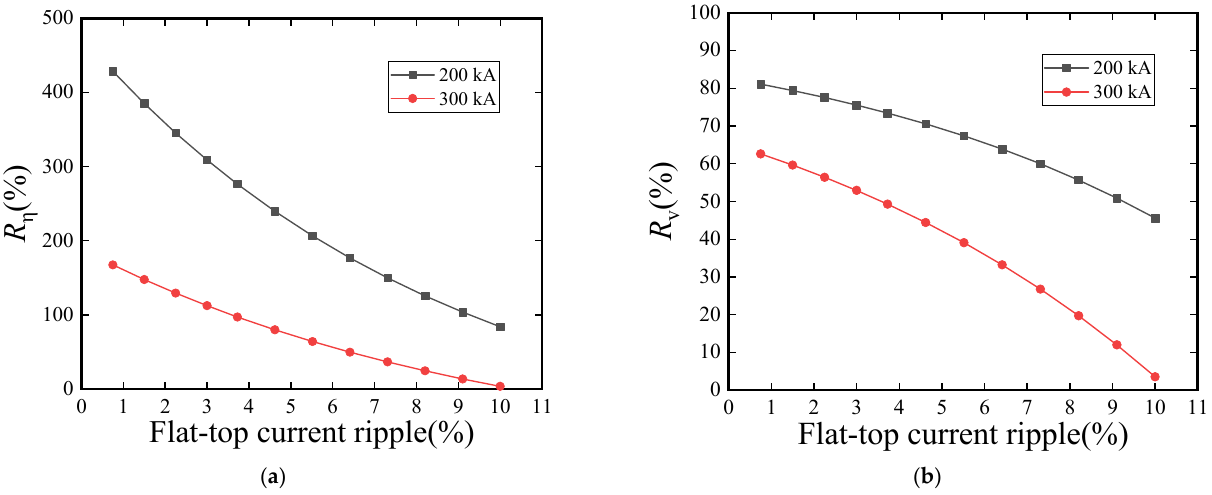
Figure 10. The optimization performance of the miniaturization transformation. ( a ) Utilization optimization performance. ( b ) Volume optimization performance.